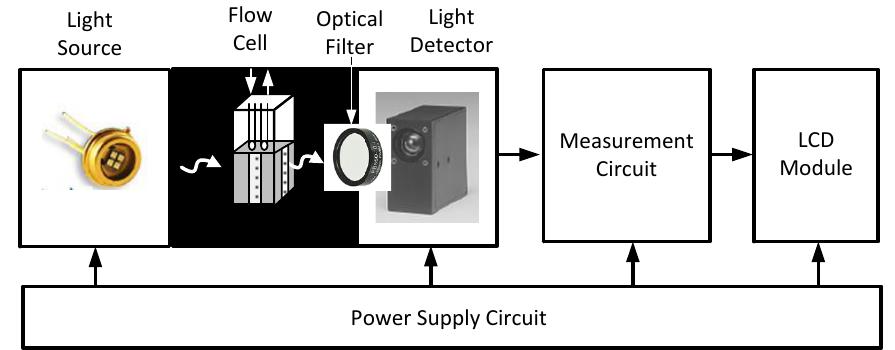
Figure 2. Block diagram of the proposed instrument system.